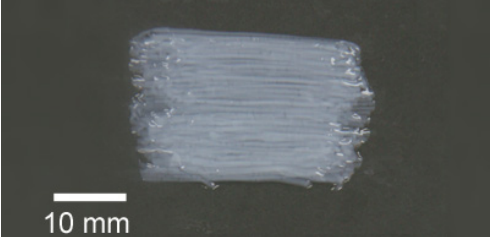
Figure 2. Arrayed oriented collagen gel strings to prepare an oriented collagen